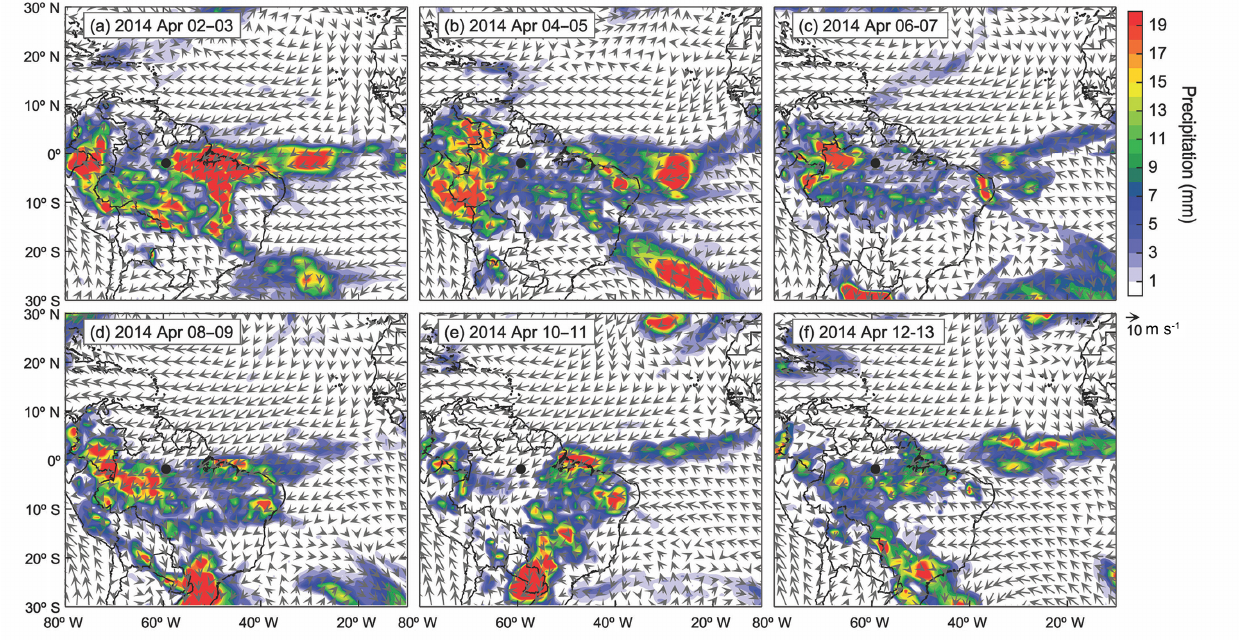
Figure 13. Wind data and precipitation daily averages from NCEP reanalysis data at a spatial resolution of 2.5 ◦ from 2 to 13 April 2014 corresponding to 2014_7 period shown in Fig.